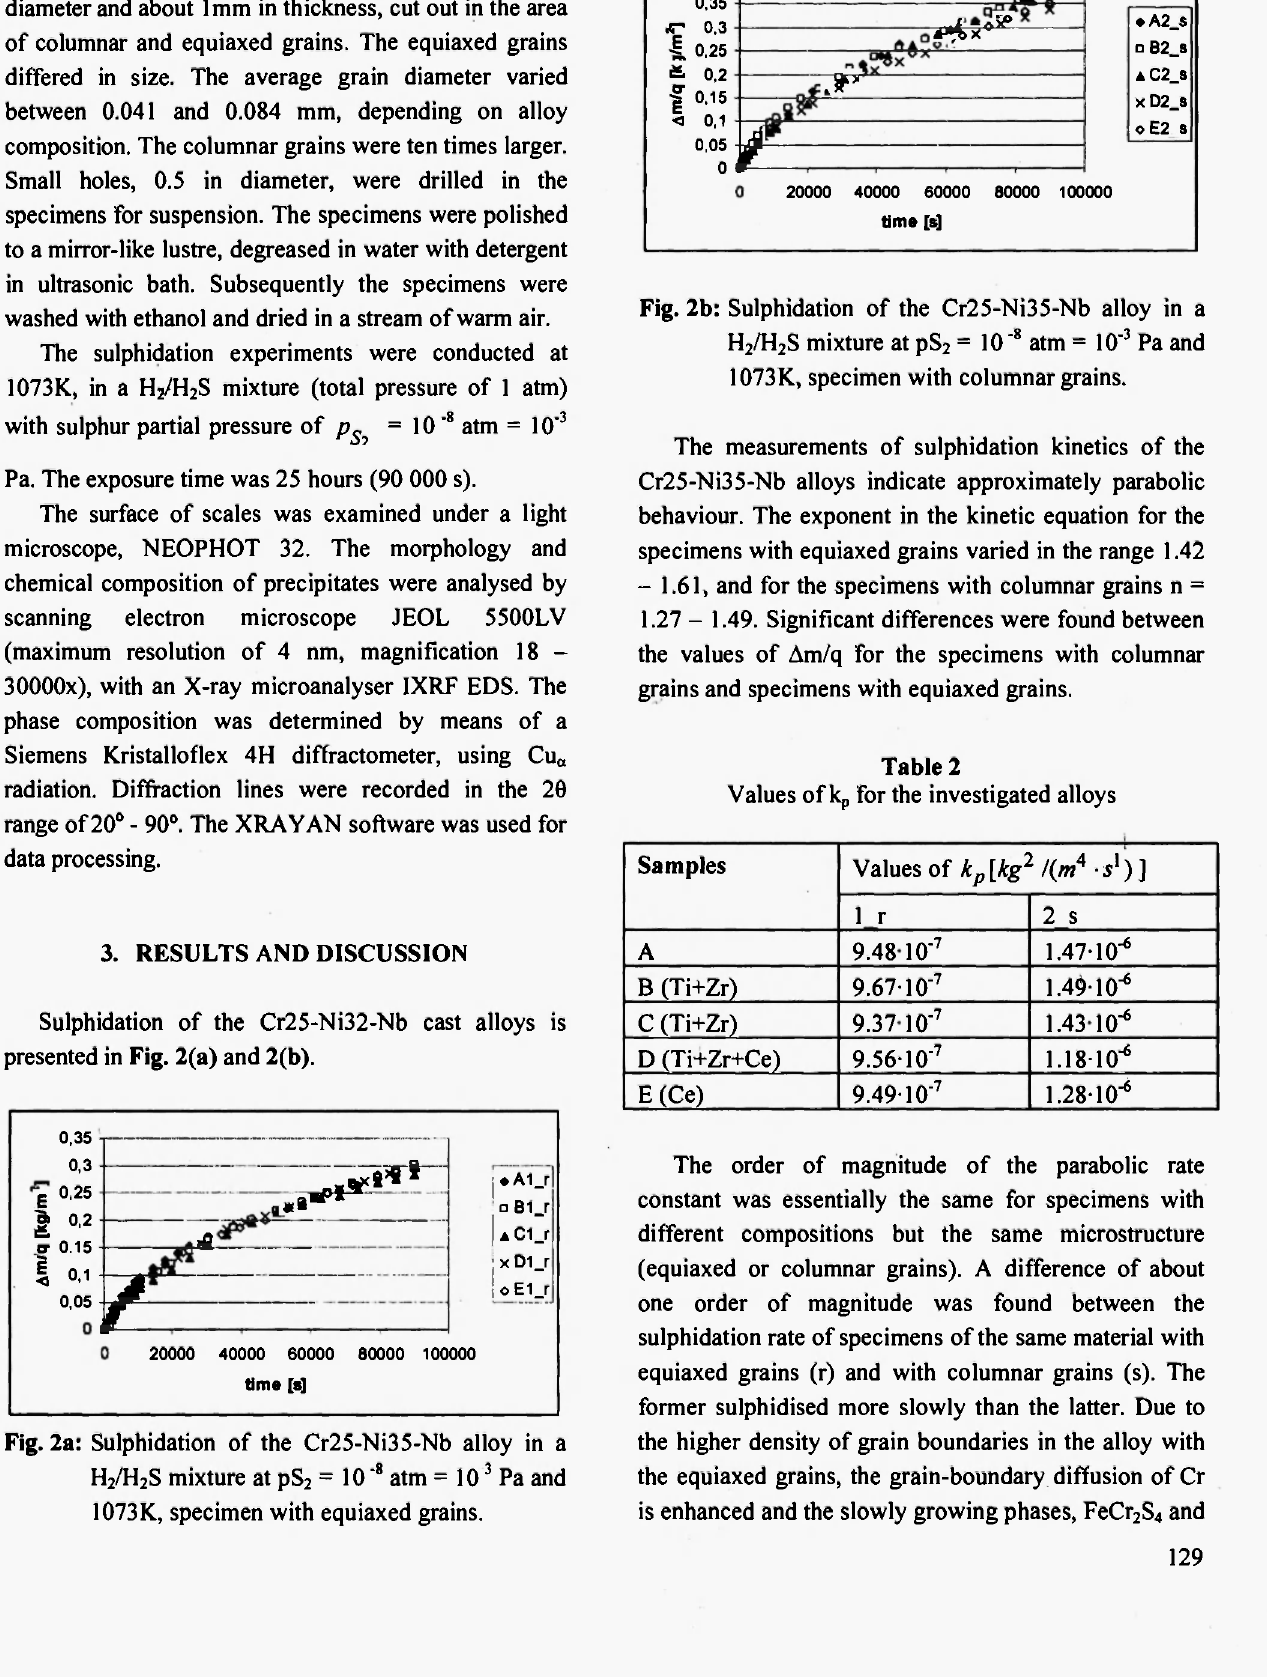
Fig. 2a: Sulphidation of the Cr25-Ni35-Nb alloy in a H 2 /H 2 S mixture at pS 2 = 10 " 8 atm = 10 3 Pa and 1073K, specimen with equiaxed grains.